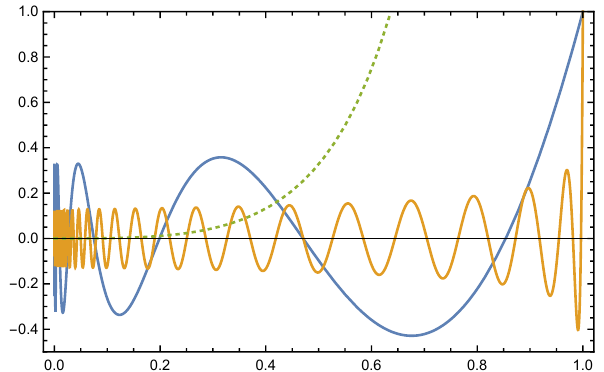
1 = 2 (cid:9) Figure 1 . Plot of z (cid:0) (cid:11) ( z ) for (cid:11) = 2 i (blue) and (cid:11) = 20 i (orange), as well as k h ( z ) for h = 3 (dotted green). Both the oscillatory behaviour of the (cid:9) (cid:11) ( z ) near z = 0 and their O ( p z ) growth are clearly